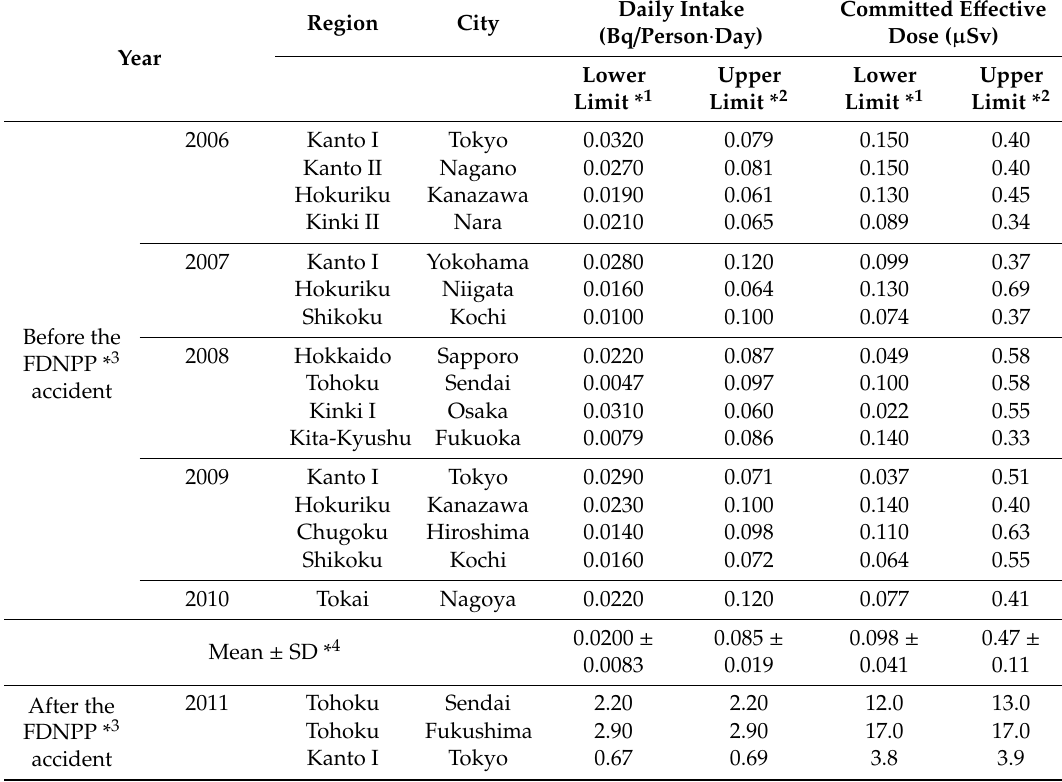
Table 4. Total daily dietary intake values and committed e ff ective doses of radioactive Cs ( 137 Cs + 134 Cs) for adults in Japan, estimated via total diet studies from 2006 to